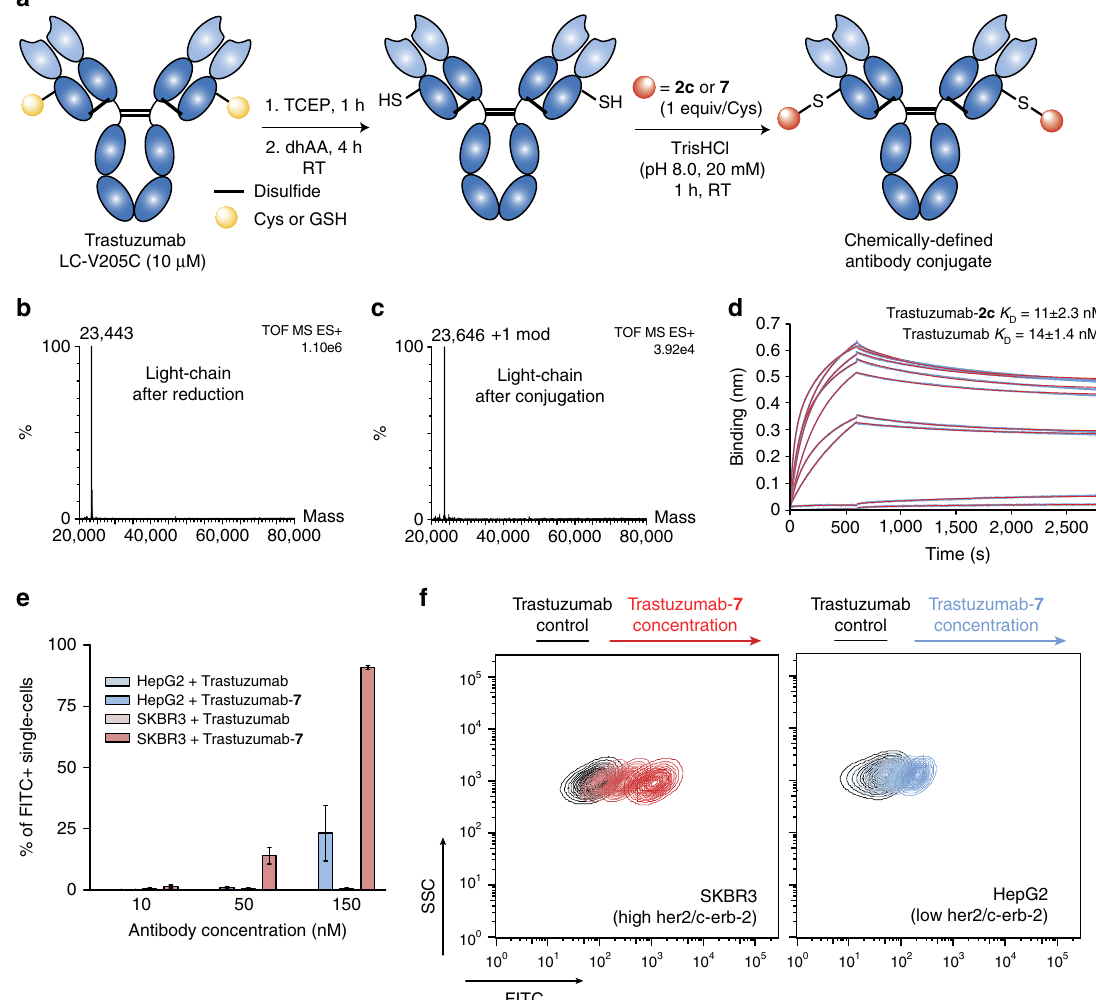
Figure 4 | Construction of homogenous and functional antibody-conjugates. ( a ) Scheme for chemoselective and equimolar bioconjugation of Trastuzumab with 2c and 7 . ( b , c ) Electrospray ionization–MS spectra of the light-chain of Trastuzumab ( b ) before and ( c ) after conjugation with 2c . ( d ) BLI curves and fit for Trastuzumab- 2c and HER2. K D constants derived from BLI experiments for non-modified Trastuzumab and conjugated Trastuzumab- 2c . ( e , f ) Analysis of specificity of the Trastuzumab- 7 towards HER2 by flow-cytometry. ( e ) Percentage of FITC-positive single cells, after treatment with fluorescent Trastuzumab- 7 or non-fluorescent Trastuzumab. ( f ) Superposition of contour plots of side-scatter detection versus FITC-equivalent fluorescence intensity, in SKBR3 cells (expressing high levels of her2/c-erb-2) and in HepG2 cells (expressing low levels of her2/c-erb-2). Controls were treated with non-conjugated Trastuzumab and samples were treated with increasing concentrations of Trastuzumab- 7 (10, 50 and 150nM). RT, room